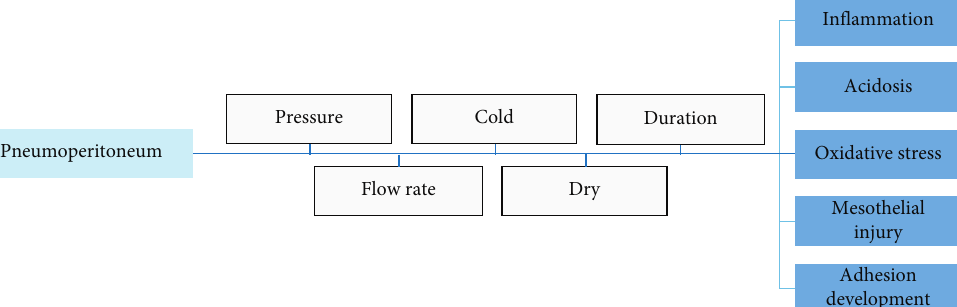
Figure 2: Pneumoperitoneum characteristics and related peritoneal